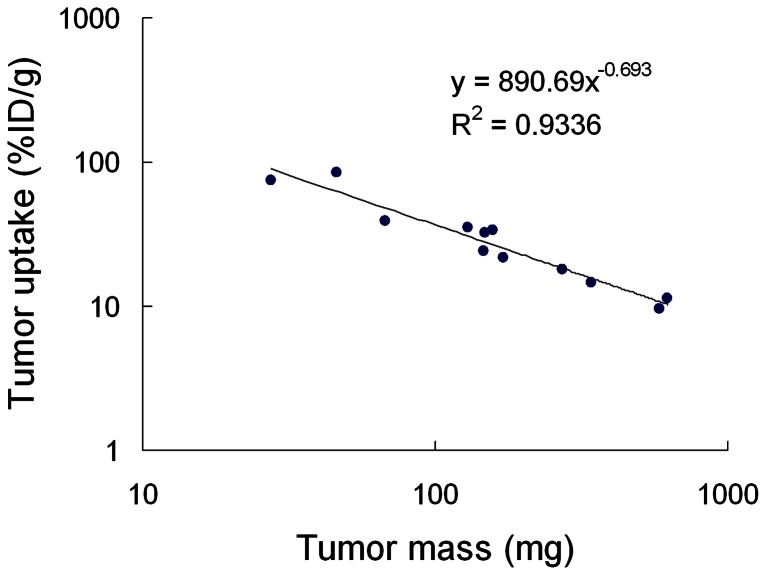
Relationship between tumor uptake (%ID/g) and tumor mass at 48 h after administration of InVNBL in mice bearing differently sized C26/tk-luc tumors.